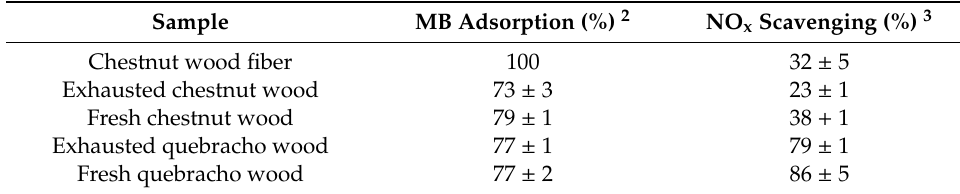
Table 4. Pollutant adsorption properties of wood samples. 1